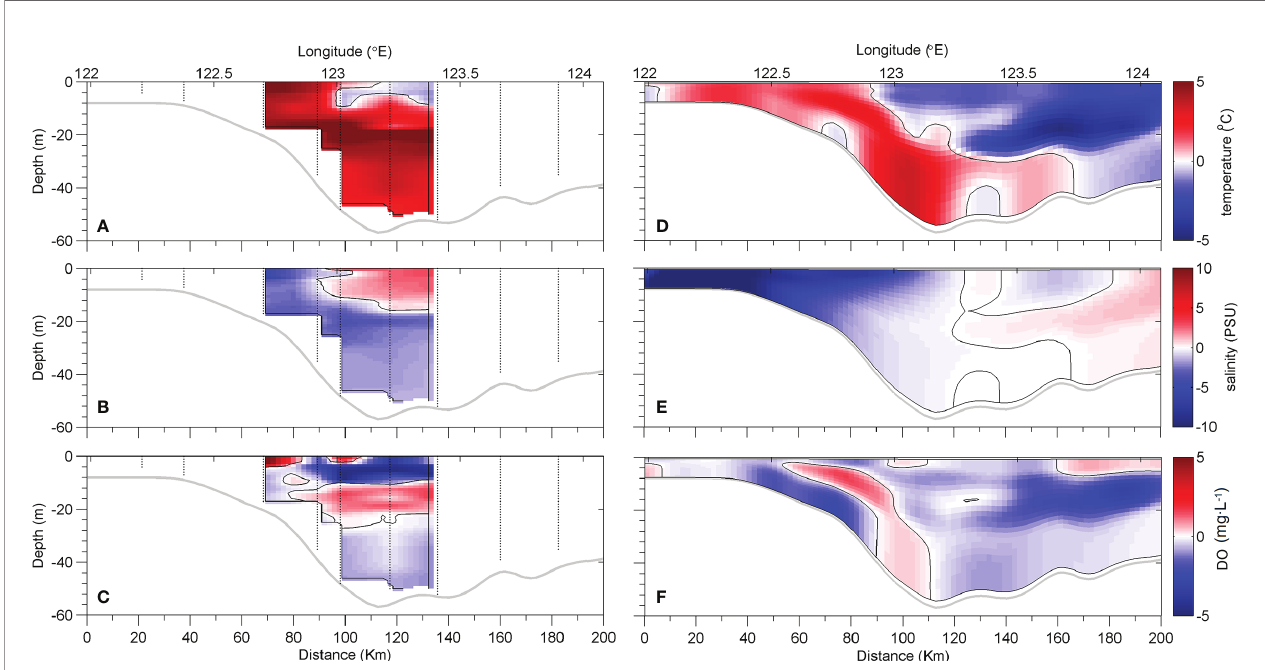
FIGURE 5 | Differences in (A) temperature, (B) salinity, and (C) dissolved oxygen (DO) found by subtracting the pro fi les at the repeated sample stations (indicated by small black dots) conducted during Leg 1 from those during Leg 2 in the survey at the 31°N transect. Differences in (D) temperature, (E) salinity, and (F) dissolved oxygen (DO) at the 31°N transect derived from the model obtained by subtracting daily mean model output on August 22, 2020 from that on August 28, 2020. Zero contour lines are plotted by thin black solid lines throughout the fi